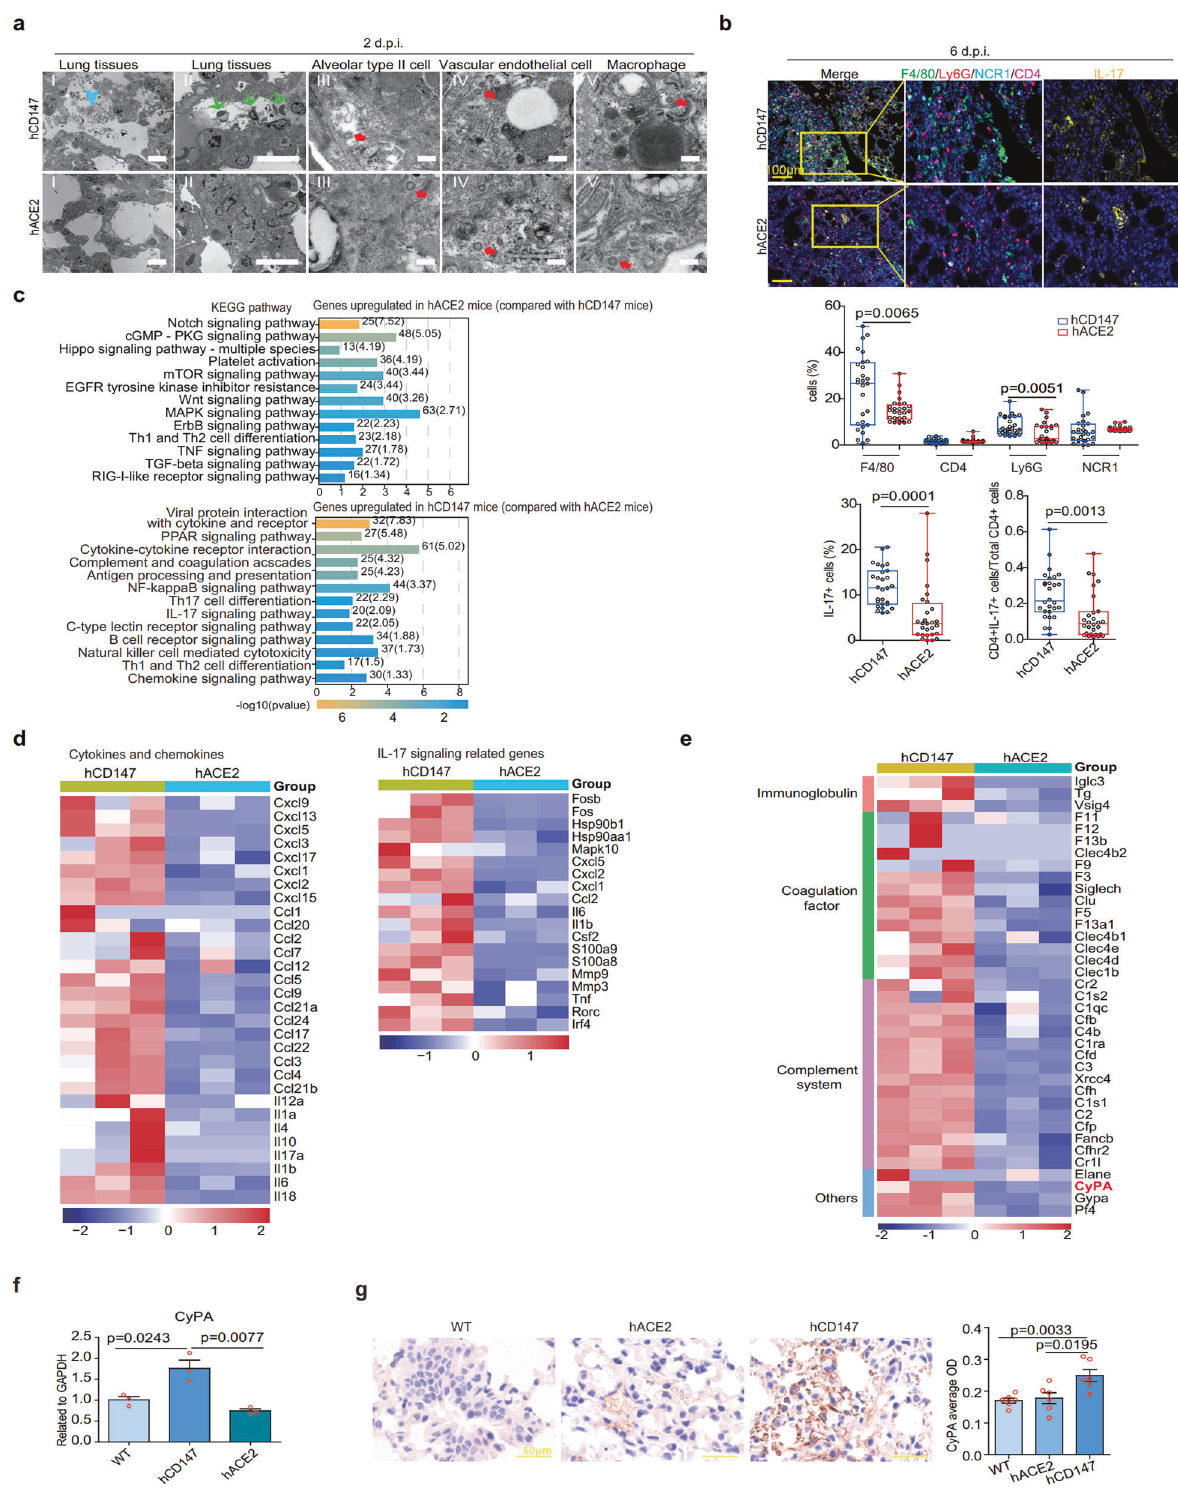
infection regardless of mutations identi fi ed so far. Therefore, Meplazumab is a promising universal and effective drug against COVID-19. With the repeated surge of COVID-19, especially the prevalence of VOCs, no ideal mouse model was yet available in evaluating vaccine protection and speci fi c and effective drugs.